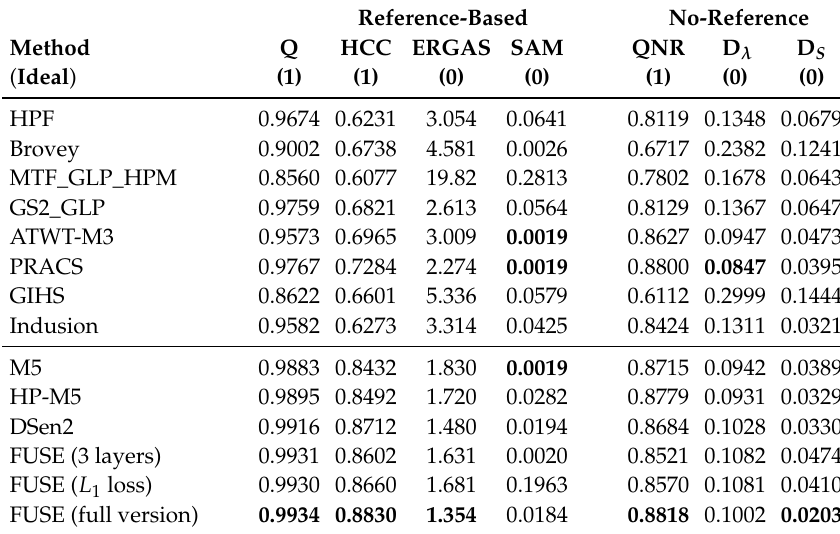
Table 4. Accuracy assessment of several super-resolution methods. On top are model-based approaches and DL methods are on the bottom, including the proposed FUSE